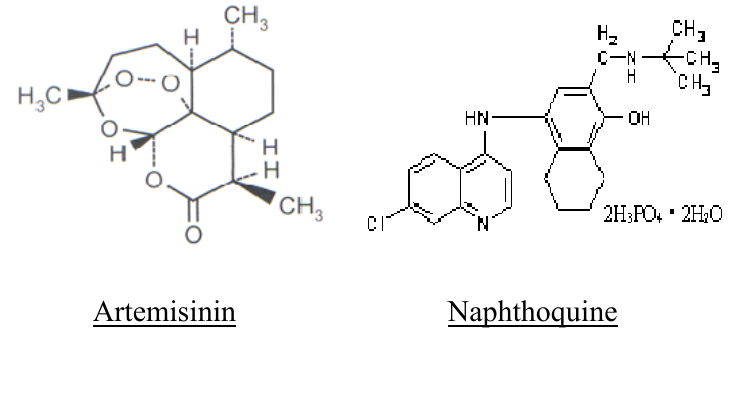
Figure 1. Chemical structure of artemisinin and naphthoquine